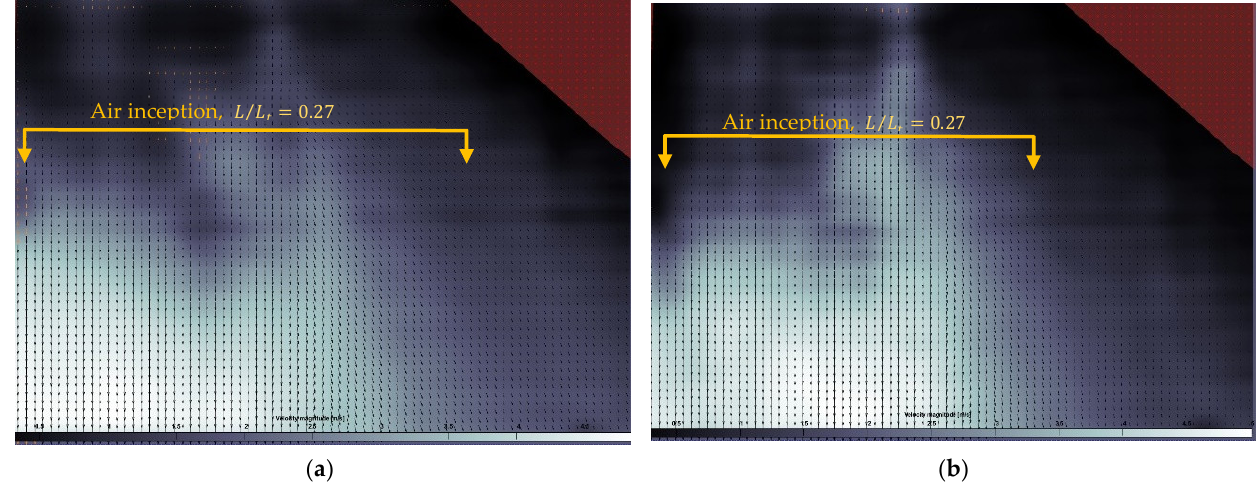
Figure 14. Velocity field obtained for d c / h = 2.38 at ( a ) 200 fps and ( b ) 400 fps.